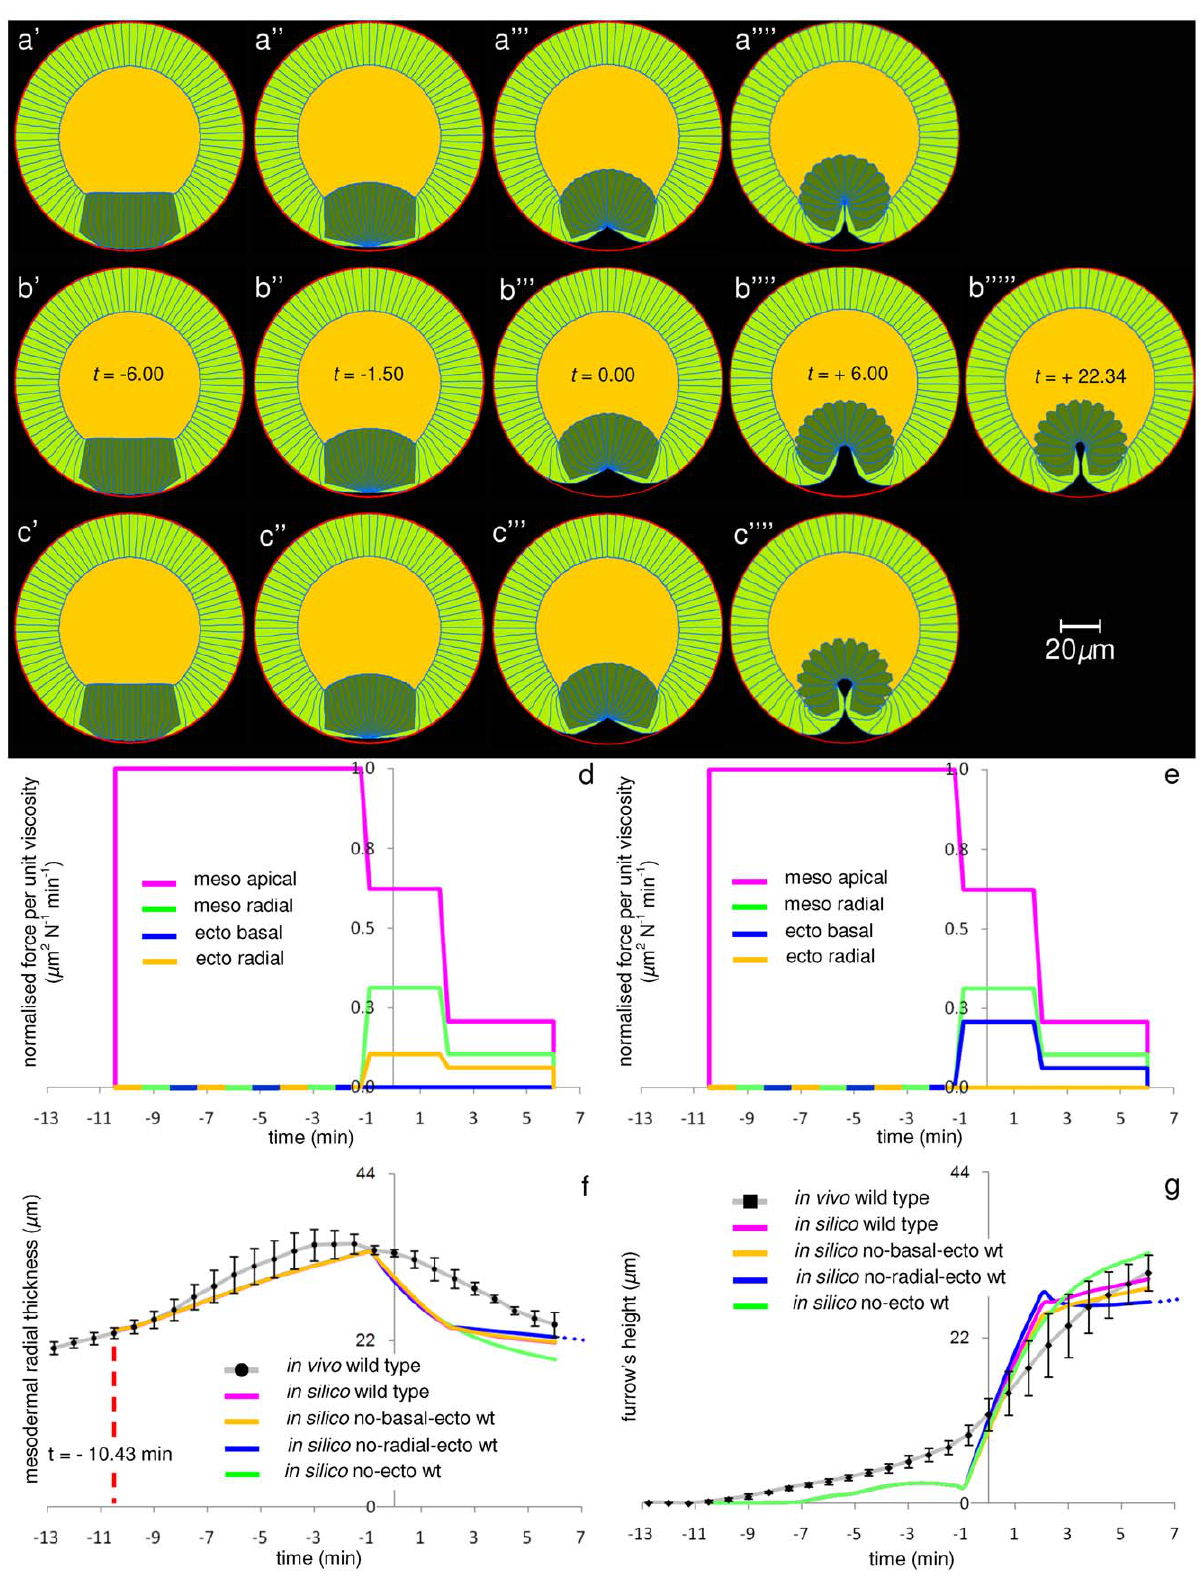
Figure 7. Ventral furrow invagination robustness to insilico ectodermal perturbations. The wild type mechanism of invagination (Fig. 3c) has been perturbed by switching on/off component forces acting in the ectoderm (blue and yellow lines). The figure shows that perturbing the wild type mechanism of invagination does not hinder ventral furrow formation, which is ultimately regained in a shorter or longer period depending on the typology of perturbation. It is worth noticing that the perturbation introduced in the invagination mechanism (see panels f–g) does not affect